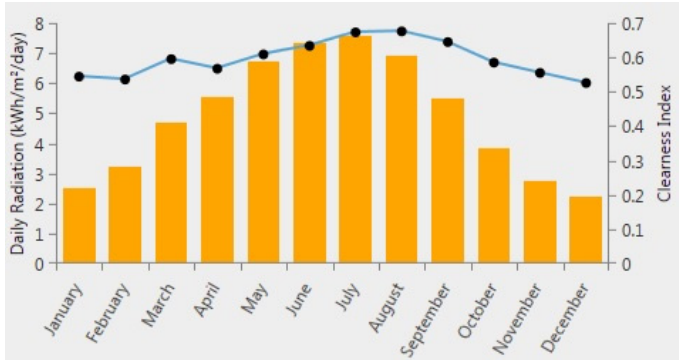
Figure 3. Daily global horizontal solar radiation and clearness index in Andalusia implemented with Hybrid Optimization of Multiple Energy Resources (HOMER)